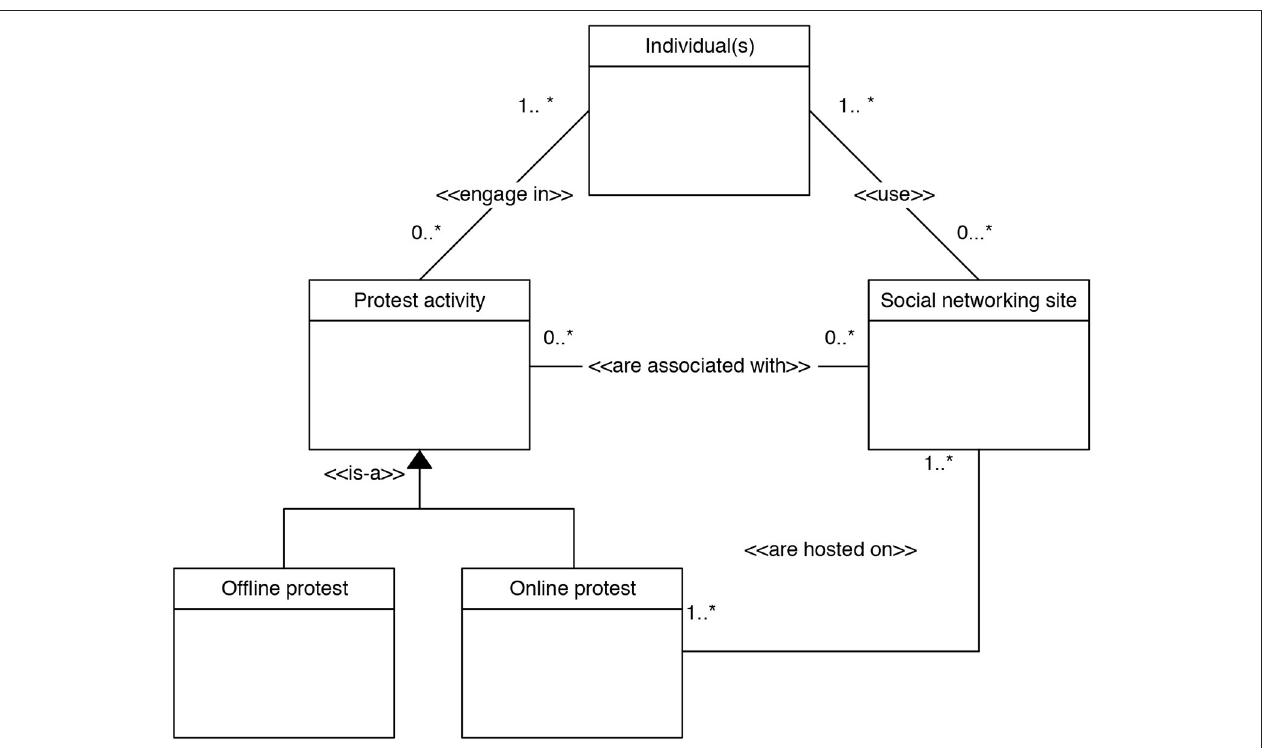
FIGURE 2 | Conceptual model of the relations between the individual, his/her participation in protest activities (online/offline) and social networking site